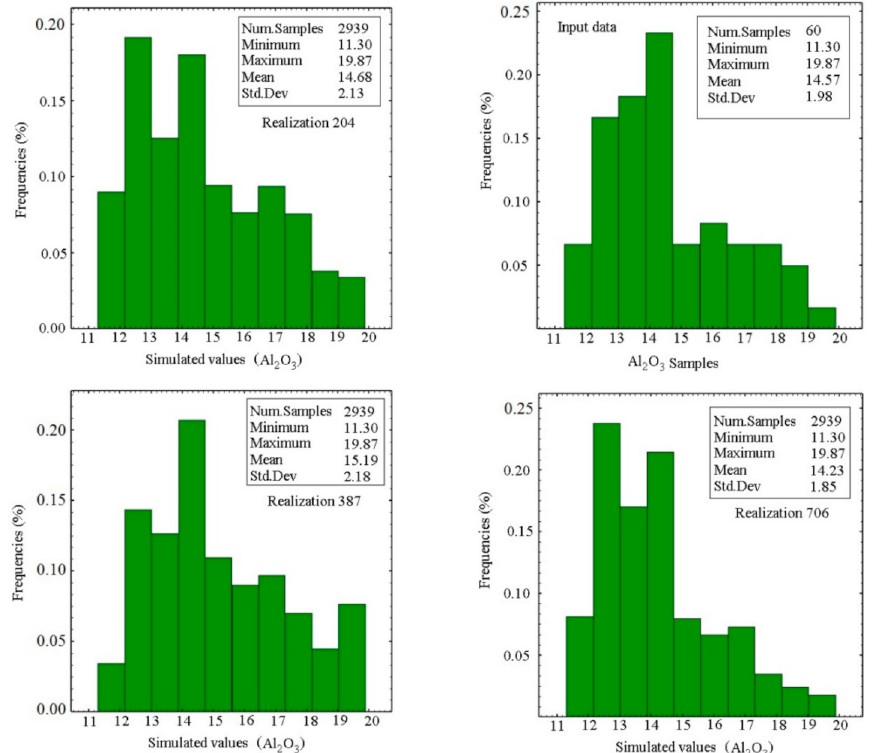
Figure 10. Comparison between the histogram and statistical parameters of the input data and the histograms of three realizations of the geostatistical simulation performed for Al 2 O 3